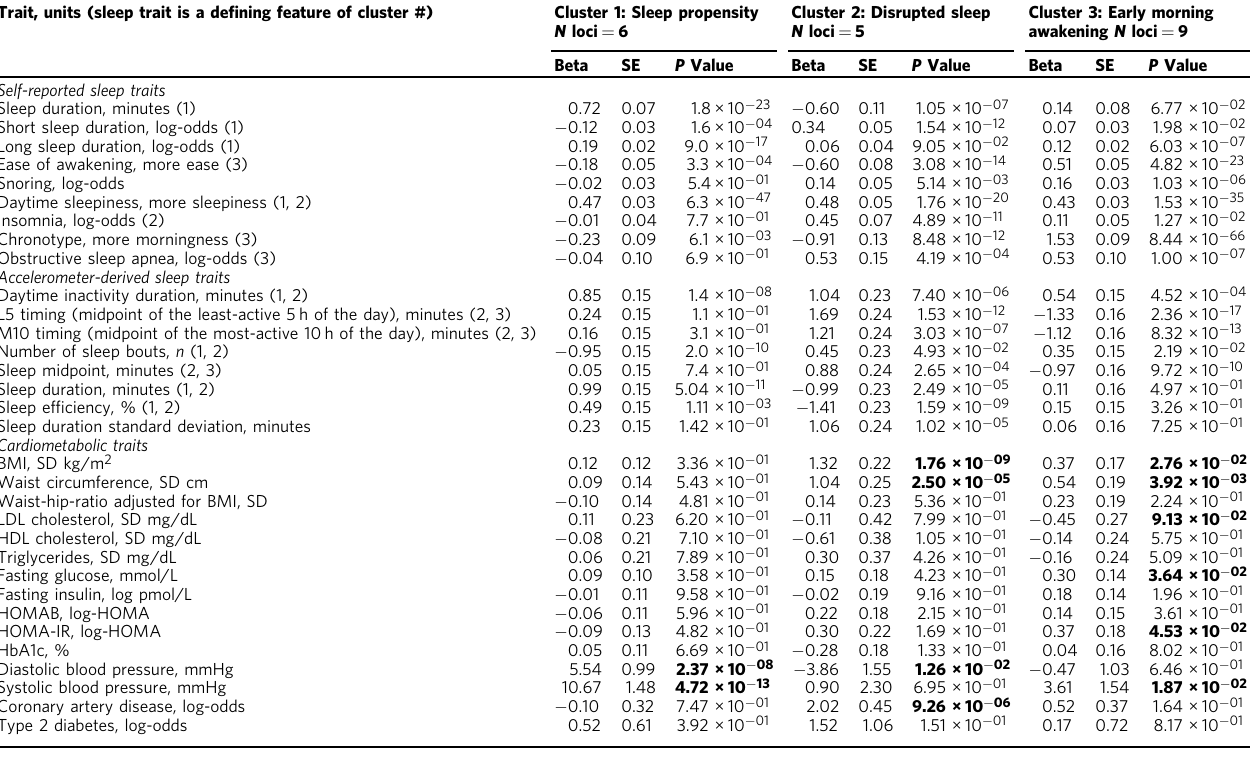
Table 1 Cluster-speci fi c daytime napping polygenic scores associations with self-reported and accelerometer-derived sleep traits and other cardiometabolic